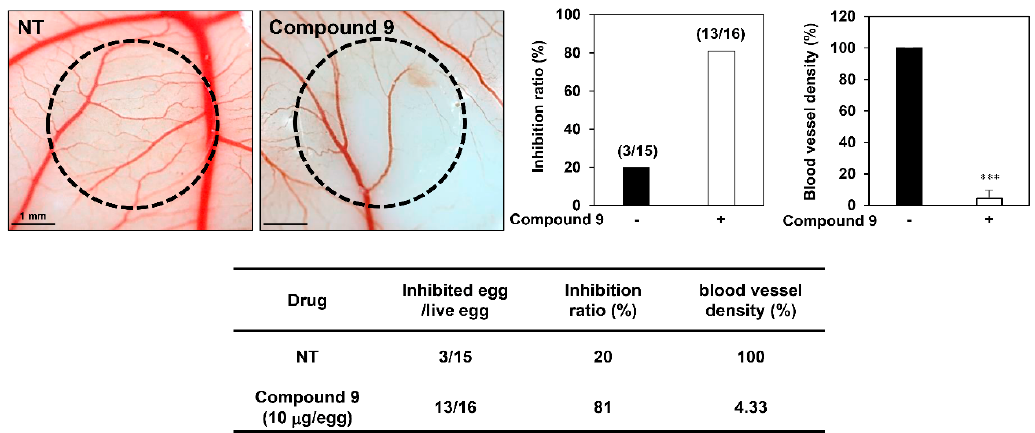
Figure 3. The in vivo antiangiogenic activity of compound 9 in CAMs. Fertilized chick eggs were maintained in a humidified egg incubator at 37 °C . At embryonic day 5, coverslips filled with vehicle alone or compound 9 (10 µg/egg) were placed to the CAM surface. Two days later, the vascular images were photographed. Calculations were based on the ratio of inhibited eggs relative to the total number of live eggs. Microvessel density was counted and the basal levels of control were normalized to 100%. *** p < 0.001 vs. the control.